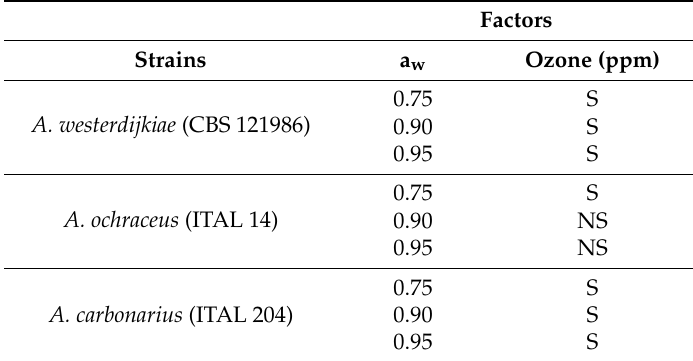
Table 1. Summary of the statistical results of O 3 treatment on ochratoxin A (ng g − 1 ) production by A. westerdijkiae , A. ochraceus , and A. carbonarius in relation to a w (0.75, 0.90, 0.95) after 12 days storage using the Kruskal–Wallis Test (non-normality data).